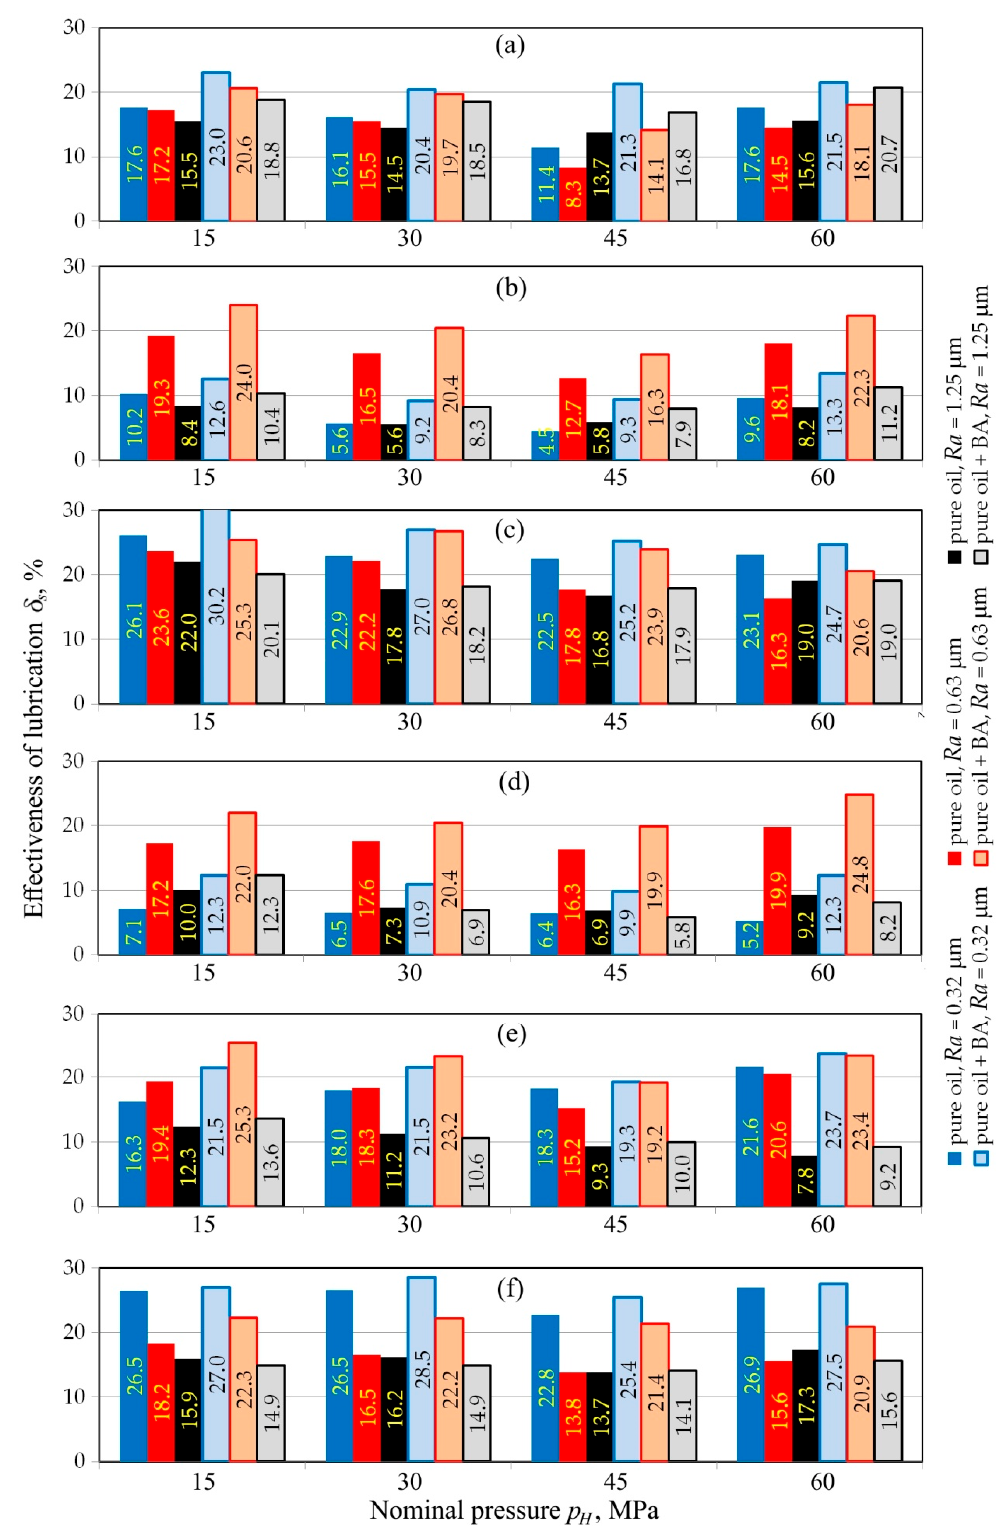
Figure 12. Comparison of the effectiveness of lubrication for tests carried out under the range of nominal pressure between 15 and 60 MPa for different oils: ( a ) linseed, ( b ) olive, ( c ) palm, ( d ) rapeseed, ( e ) soybean, ( f ) sunflower.